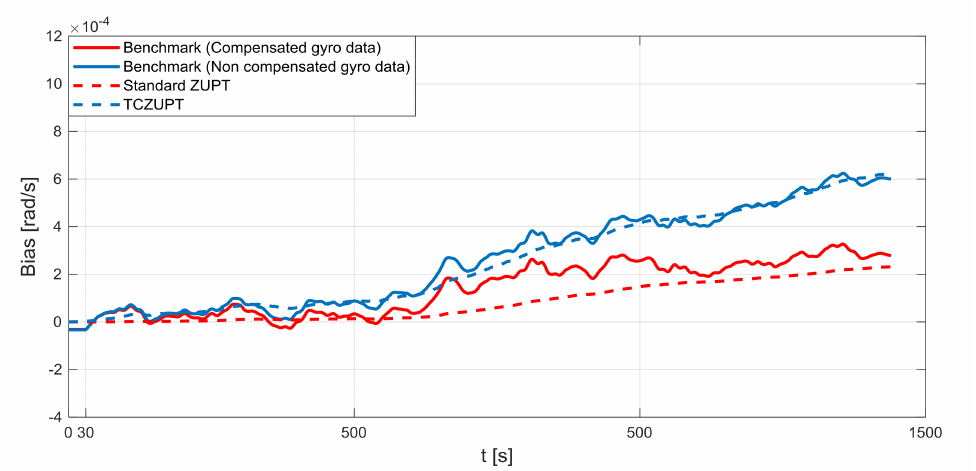
Figure 12. Gyro output bias (nominal condition, y -axis).